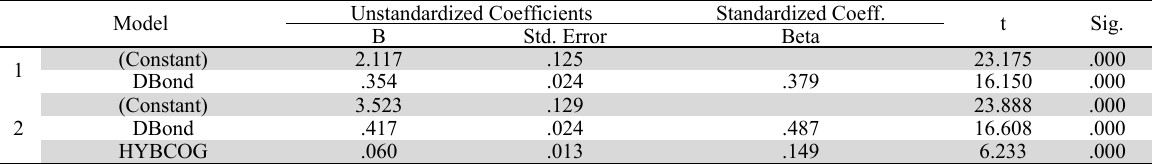
Coefficient a Model